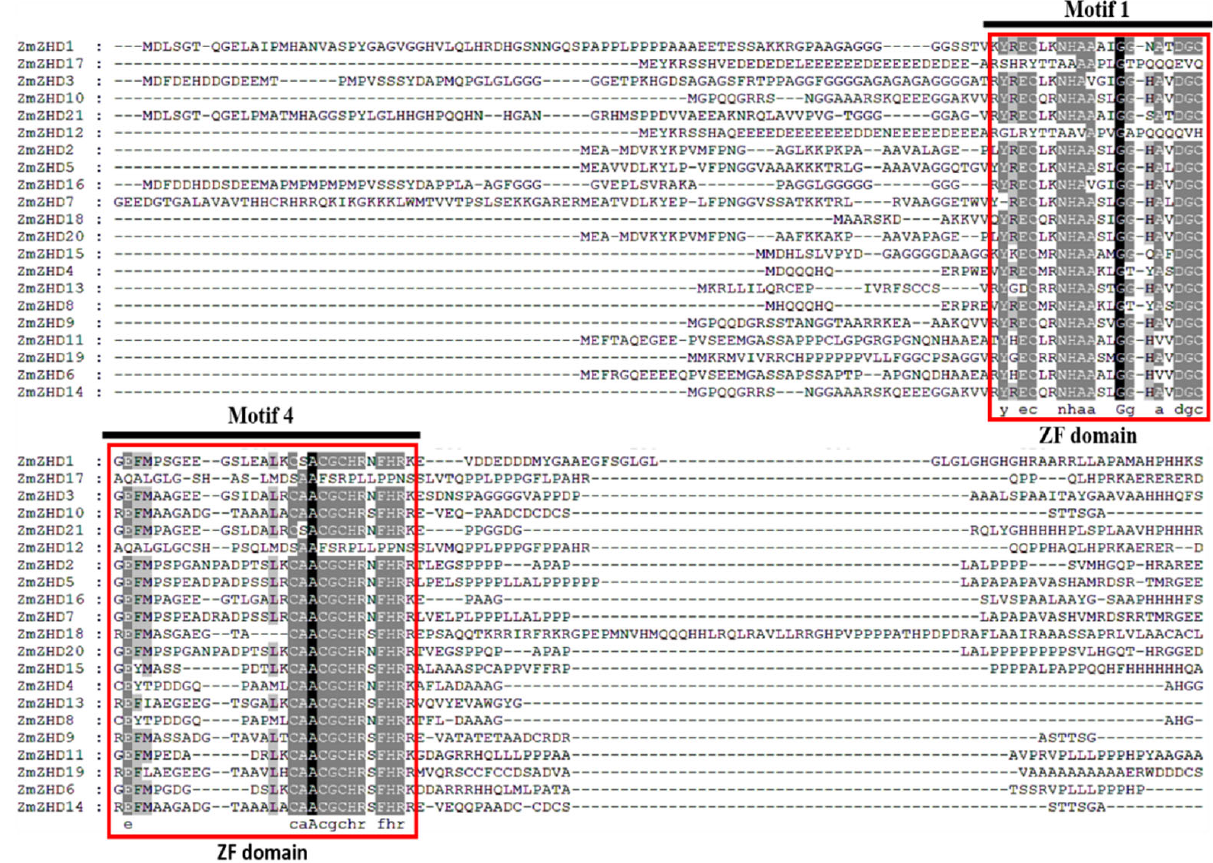
Figure 1. Multiple sequence alignment of the conserved domains of the members of the ZmZHD gene family in maize. Motifs 1 and 4 represent ZF domains.